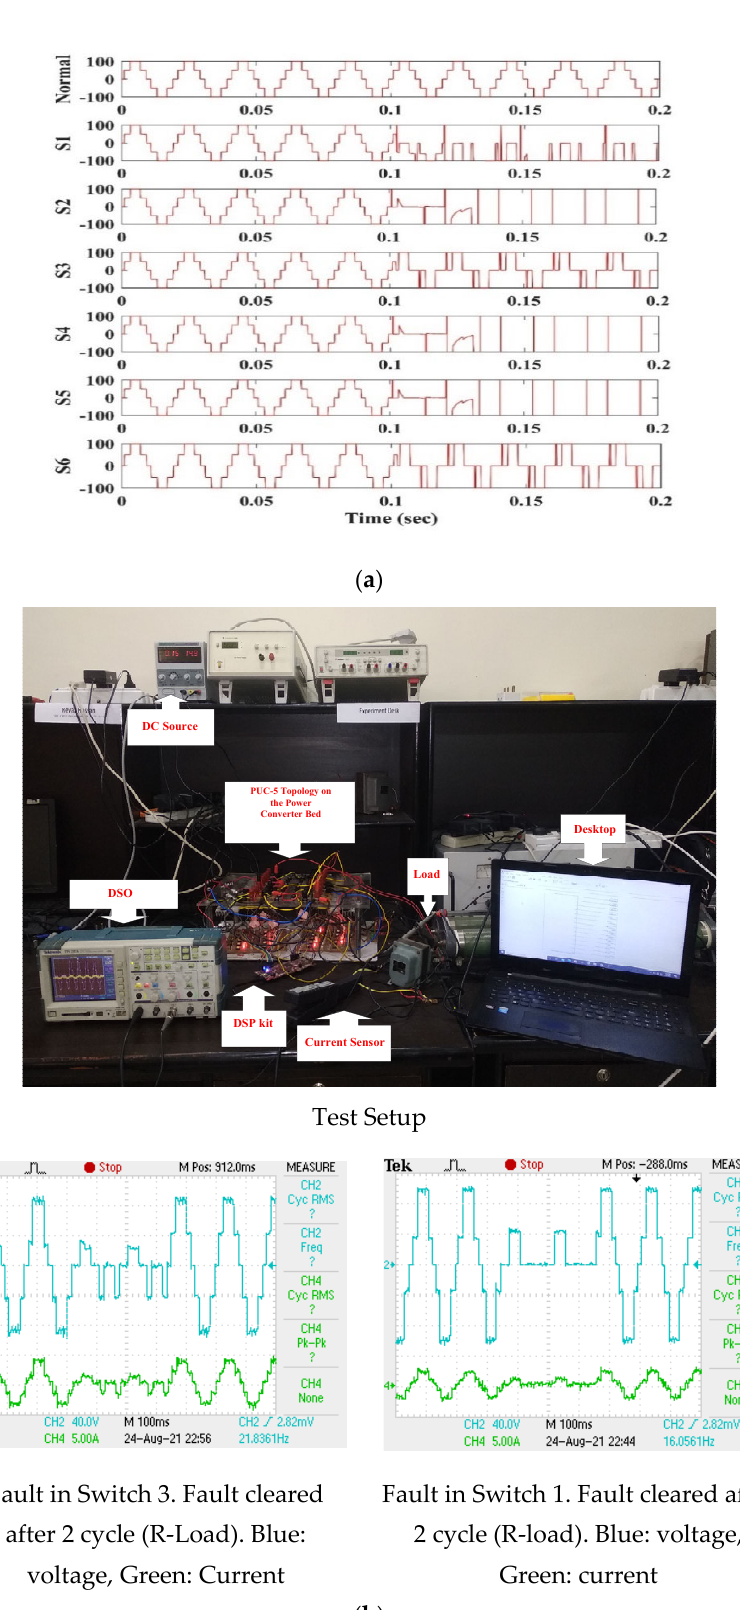
Figure 2. ( a ) Simulated output voltage waveforms under various faults. ( b ) Experimental output voltage waveforms under two different switch faults.